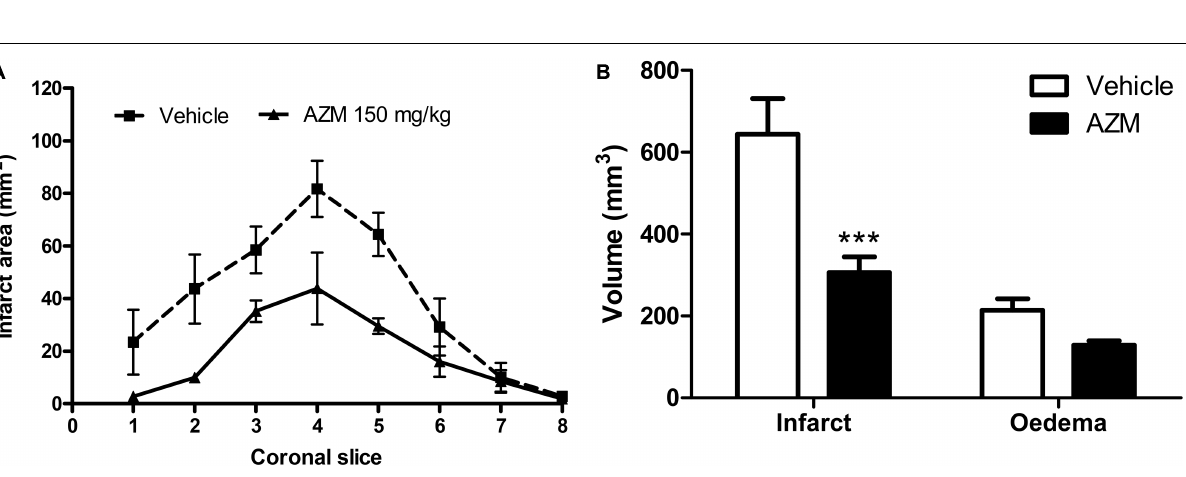
Frontiers in Neuroscience |